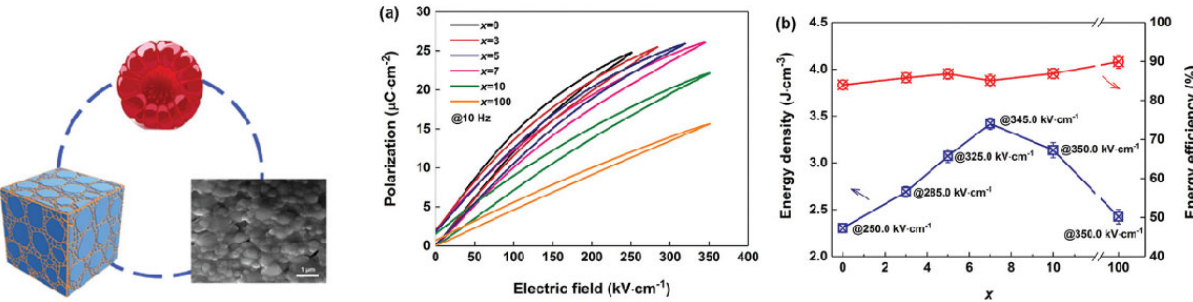
Fig. 6 Schematic of BT–BMZ-based raspberry-like hierarchically structured ceramics. (a) P – E loops and (b) energy-storage properties at room temperature for ceramics with various BT–BMZ@SiO 2 contents. Reproduced with permission from Ref. [33], © WILEY-VCH Verlag GmbH & Co. KGaA, Weinheim